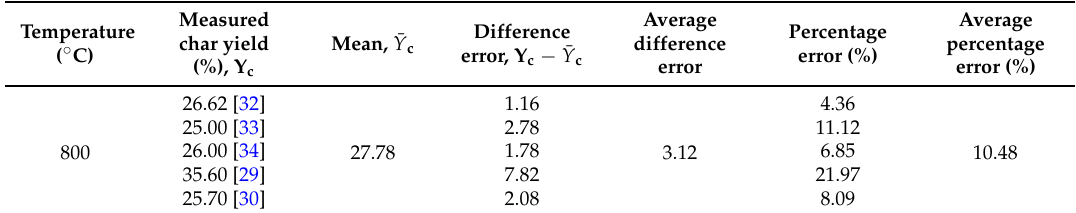
Table 3. Experimental error of six BA-a char yield measurements reported at the same temperature (800 ˝ C) and heating rate (10 K/min).